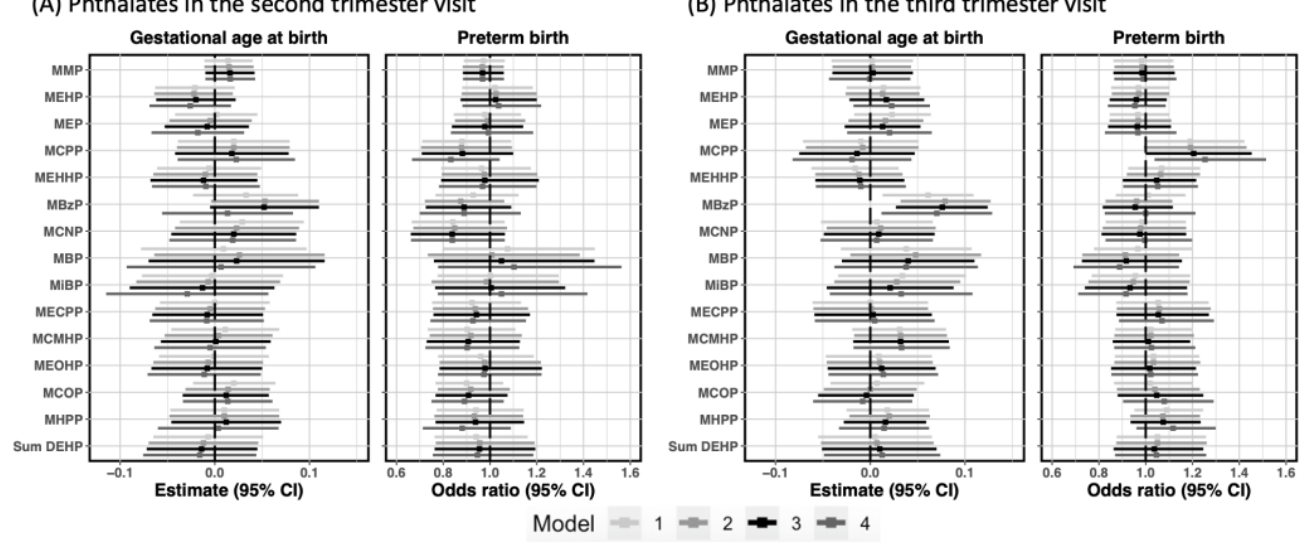
Figure 2. Estimated associations between prenatal phthalates in each visit and preterm birth in CANDLE participants. Model 1 adjusted for maternal race (Black vs. non-Black) and maternal age at delivery. Model 2 additionally controlled for maternal education (high school and less vs. above high school), income adjusted for household size, marital status (Married vs. Widowed/Divorced/Separated/Never mar- ried vs. Living with partner), insurance coverage (No insurance/Medicare or Medicaid Only vs. Medicare/Medicaid + Private/Private only), SG adjusted urinary cotinine measurements in the sec- ond trimester, and medical history of preterm birth (Yes vs. No). Model 3 was further adjusted for pre-pregnancy body mass index (BMI) class (Under vs. normal vs. overweight vs. obesity) and par- ity (0 vs. 1/2 vs. >=3). Model 4 was extensively adjusted for individual phthalates in the other tri- mester. The estimates were obtained from the models with continuous gestational age, and were interpreted as two-fold increase for each individual phthalate. The odds ratio was interpreted as two-fold increase for each individual phthalate. For each 2-fold increase in the second trimester MBzP concentrations, we observed a positive association of 0.05 more gestational weeks ( 𝛽 : 0.05, 95% CI: − 0.01, 0.11) while each 2-fold increase in the third trimester was associated with 0.08 more gestational weeks ( 𝛽 : 0.08, 95% CI: 0.03, 0.12). In the model with mutual adjustment for both trimesters, the association remained only for the third trimester ( 𝛽 : 0.07, 95% CI: 0.01, 0.13). When LPTB was analyzed as a dichotomous outcome, we observed increased odds of LPTB (OR: 1.21, 95% CI: 1.00, 1.45) in relation to MCPP in the third trimester, which was strengthened when adjusting for MCPP in the second trimester (OR: 1.25, 95% CI: 1.04, 1.51). Neverthe- less, in the mutually adjusted model, the association between second trimester MCPP and LPTB reversed to negative. Evaluation of associations between phthalates in each visit and birth outcomes were not modified by maternal race (Figure A1). No modification by IPV for the associations of interest was found (Table A3). When the analyses of individual phthalates and GA/LPTB were repeated using complete data, findings agreed with those obtained using multiple imputation (Figure A2). When MBzP in the third trimester was divided into quartiles, we found longer gestation in women with MBzP in the 2nd to 4th quartiles compared to women with MBzP in the 1st quartile (Figure A3). The smooth effect curves generated from GAMs based on complete data (Figure A4) was consistent with a linear trend for the association between MBzP in the third trimester and gestational week ( p : 0.001). When restricting the study population to those with a spontaneous labor, we ob- served similar associations with MBzP as those in the primary analysis. An association between MBzP in the third trimester and longer gestation was detected in the overall sam- ple ( 𝛽 : 0.08, 95% CI: 0.03, 0.12) (Figure 3).